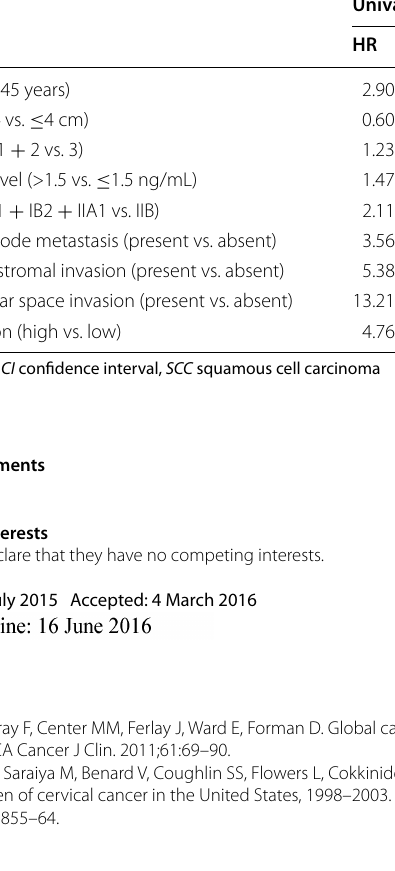
0.008); b the 5‑year DFS rate was similar =